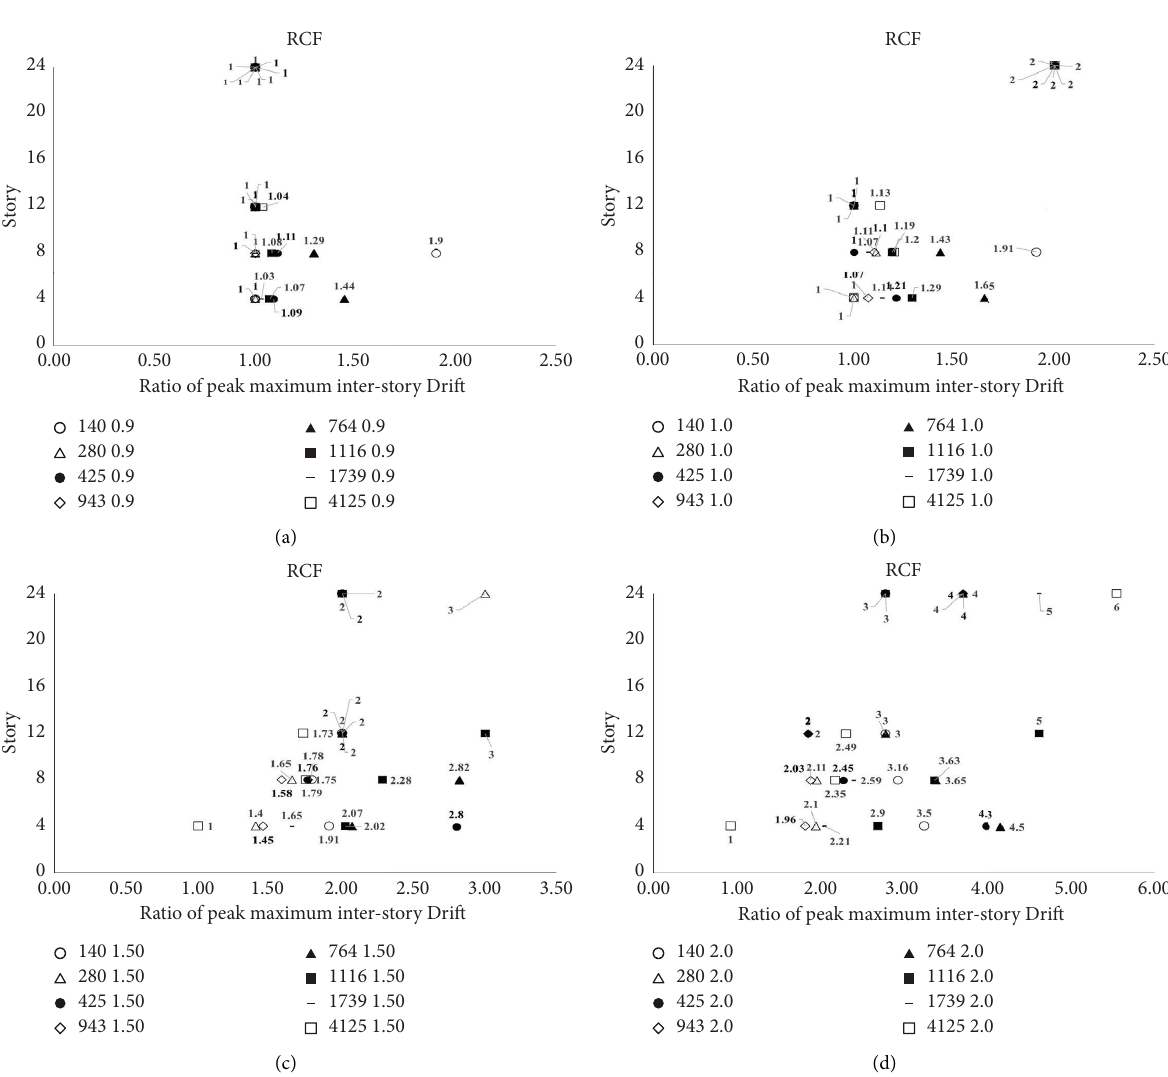
Figure 21: Ratio of the peak maximum interstory drift demand of the real SS of the models to the MS demands under in RCF without SPSW: (a) Scale 0.9, (b) scale 1, (c) scale 1.5, (d) scale